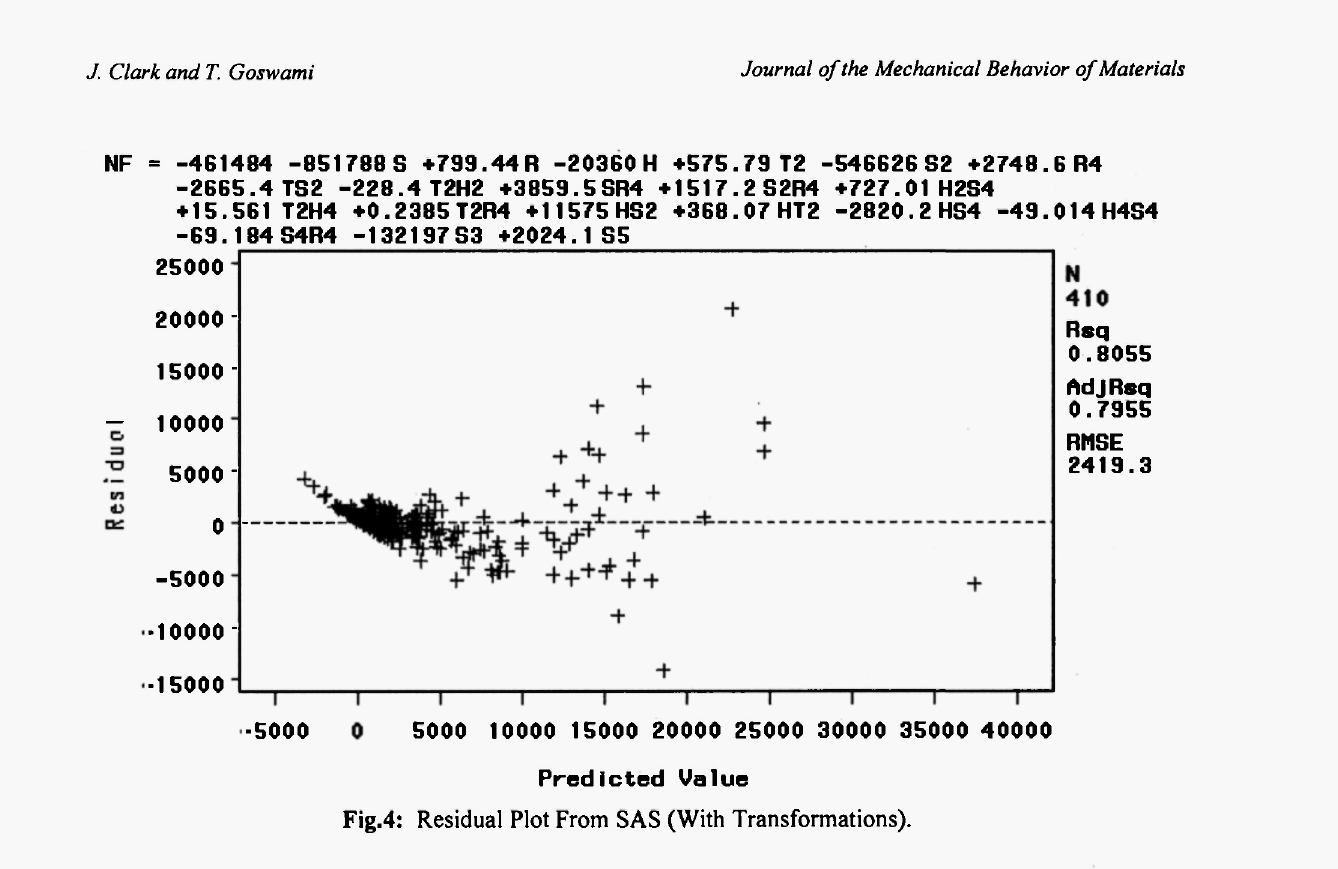
Fig.4: Residual Plot From SAS (With